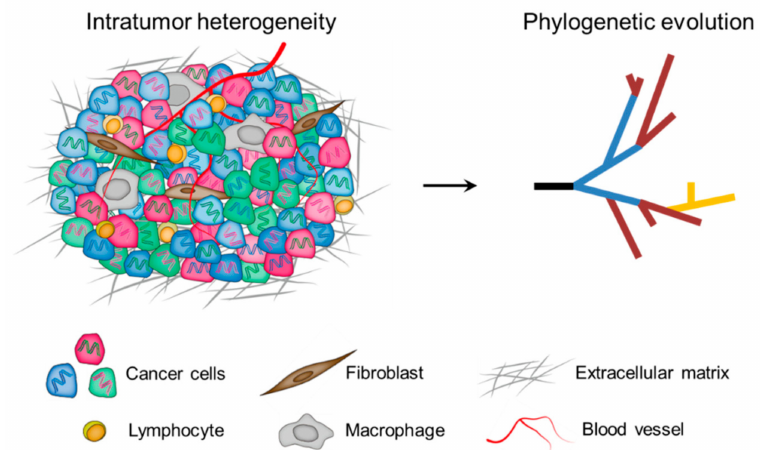
Figure 1. Multiple layers of intratumor heterogeneity. Left : Phenotypically distinct cancer cells with both genomic (DNA color) and epigenomic (cell color) heterogeneity are admixed with diversified microenvironmental components. Right : A phylogenetic framework helps to understand the nature and biological significance of tumor spatiotemporal